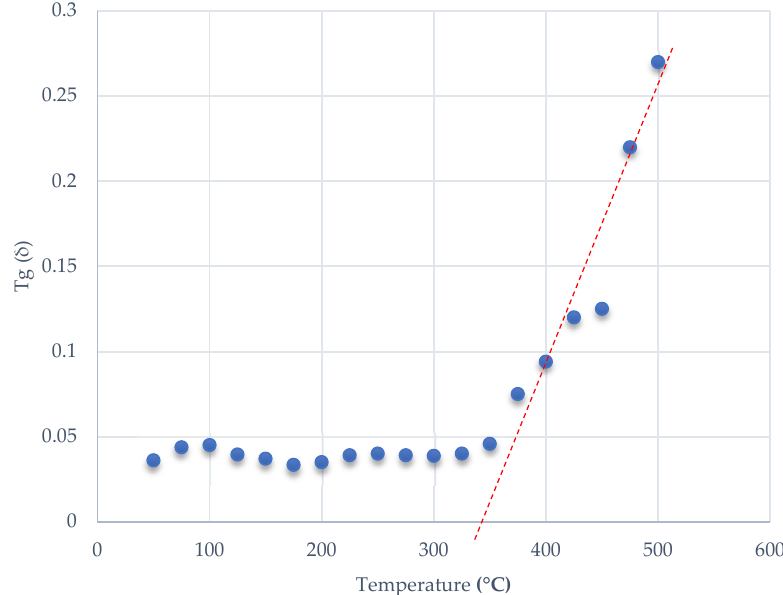
Figure 7. Temperature dependence of the dielectric loss.